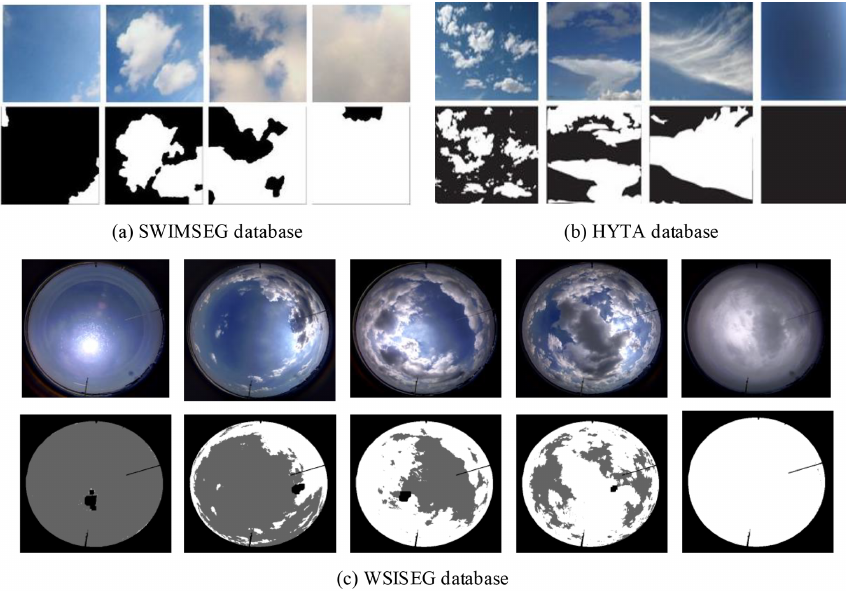
Figure 2. Representative sky images and their corresponding labels from the (a) SWIMSEG database, (b) HYTA (hybrid thresholding algorithm) database, and (c) WSISEG database. The labels of the SWIMSEG and HYTA databases are binary images, where zero represents clear sky and one represents cloud. The labels of the proposed WSISEG database, namely, clouds, sky, and undefined areas (including sun and backgrounds), are marked with gray values 255, 100, and 0, respectively. In comparison with SWIMSEG and HYTA databases, the proposed WSISEG database has more advantages to reflect the whole-sky